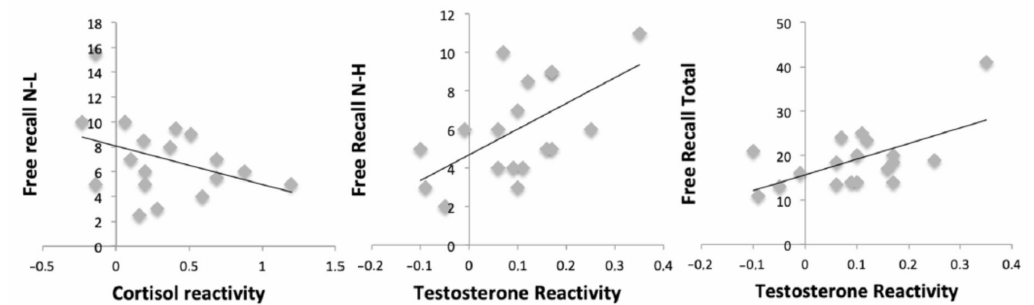
Figure 6. Scatterplots between hormonal reactivity to the Maastricht Acute Stress Test (MAST) and free recall